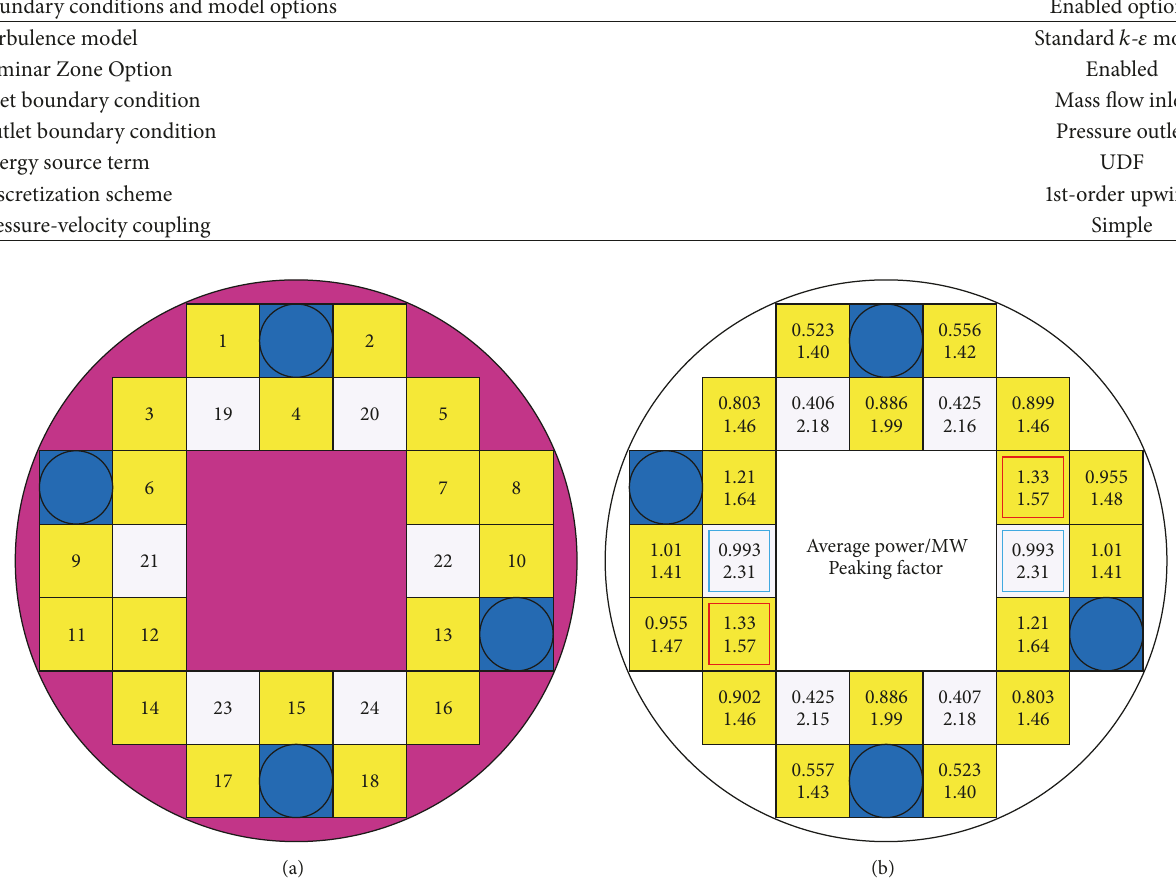
Figure 4: Fuel assembly number and average power and peak factor of each fuel assembly in the HFRR [9]: (a) fuel assembly number; (b) average power and peak